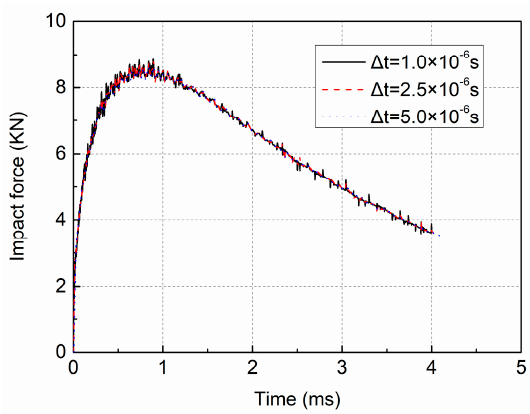
Figure 4. The impact force with different time-steps during the free-fall water entry of the sphere.